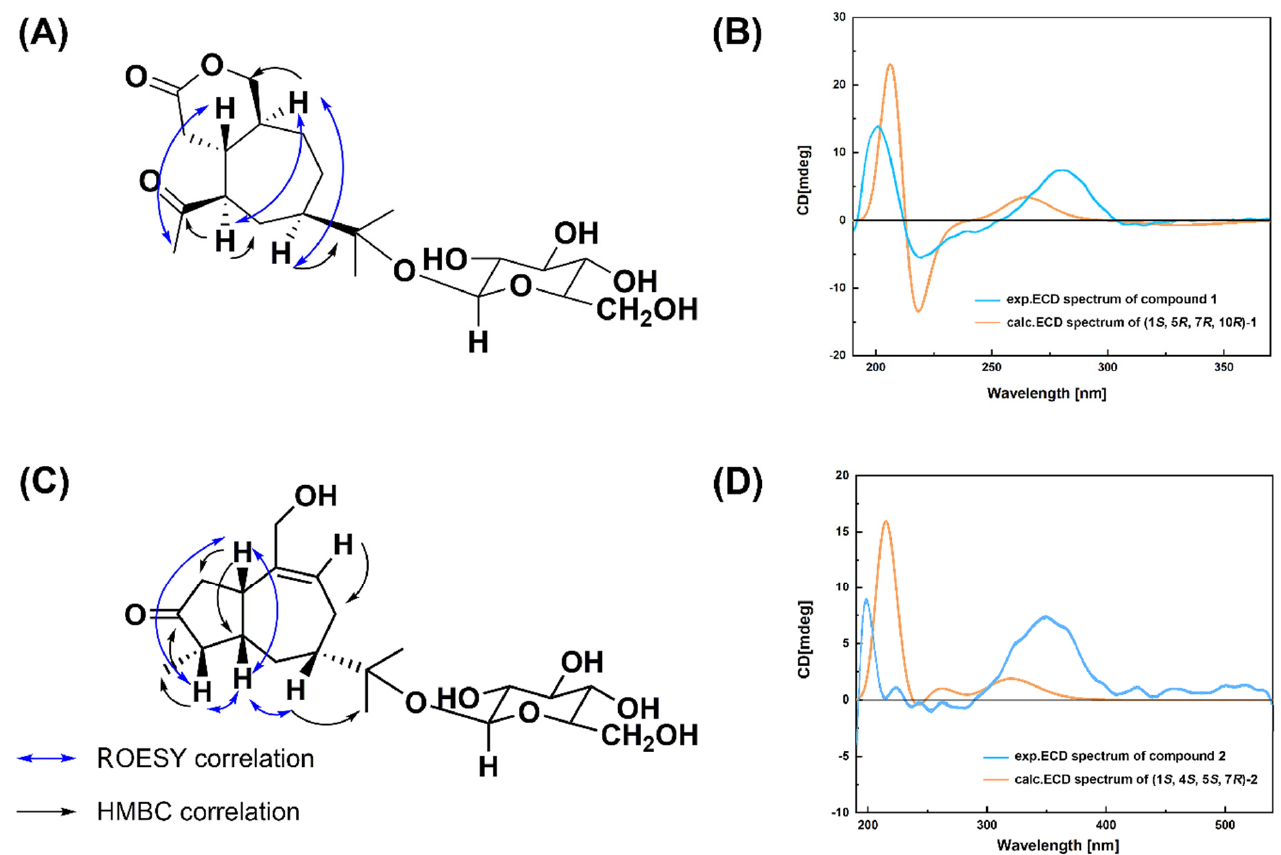
Figure 2. The key 2D NMR correlations and the ECD spectra of compound 1 ( A , B ) and compound 2 ( C , D ).